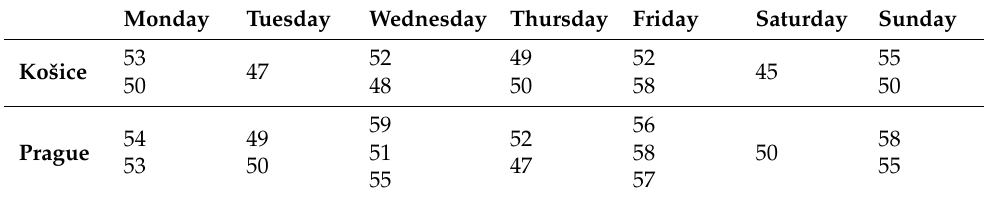
Table 1. Number of passengers on individual